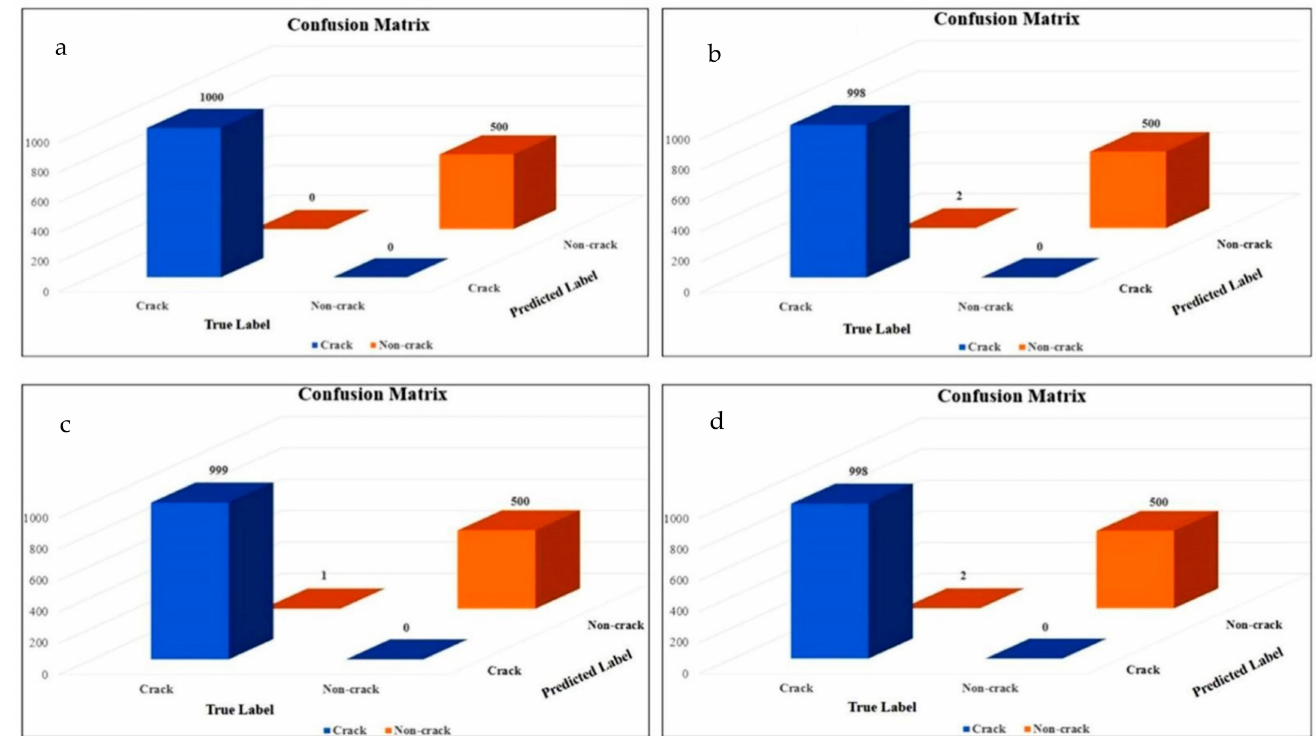
Figure 11. The confusion matrix of Xception_71 test on the test dataset 1 ( a ), 1a ( b ), 1b ( c ), and 1c ( d ).